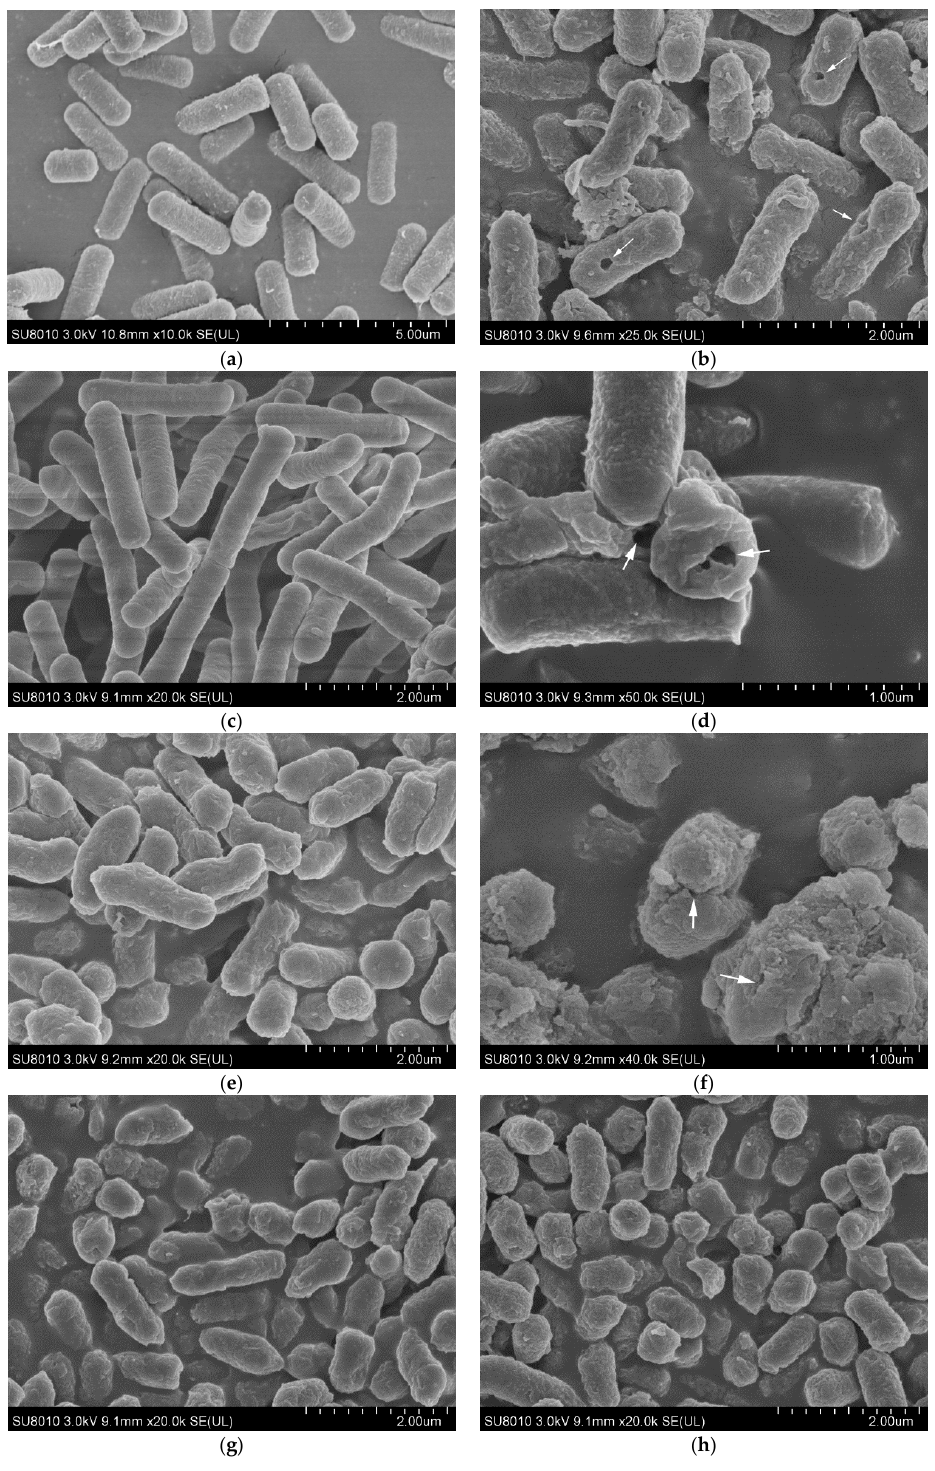
Figure 3. ( a ) SEM of L. monocytogenes control (magnification, × 10,000); ( b ) SEM of L. monocytogenes after treatment with 1 × MIC SML for 24 h (magnification, × 25,000); ( c ) SEM of B. subtilis control (magnification, × 20,000); ( d ) SEM of B. subtilis after treatment with 1 × MIC SML for 24 h (magnification, × 50,000); ( e ) SEM of S. aureus control (magnification, × 20,000); ( f ) SEM of S. aureus after treatment with 1 × MIC SML for 24 h (magnification, × 40,000); ( g ) SEM of E. coli control (magnification, × 20,000); ( h ) SEM of E. coli after treatment with 1 × MIC SML for 24 h (magnification, × 25,000). White arrows indicate the pore-like